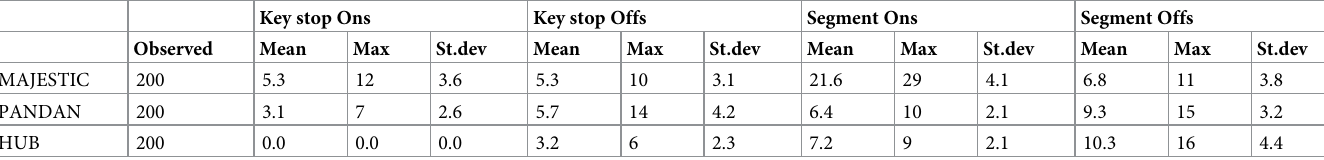
Table 5. Route U32 passenger activity statistics summary; AM peak, in-bound. Key stop Ons